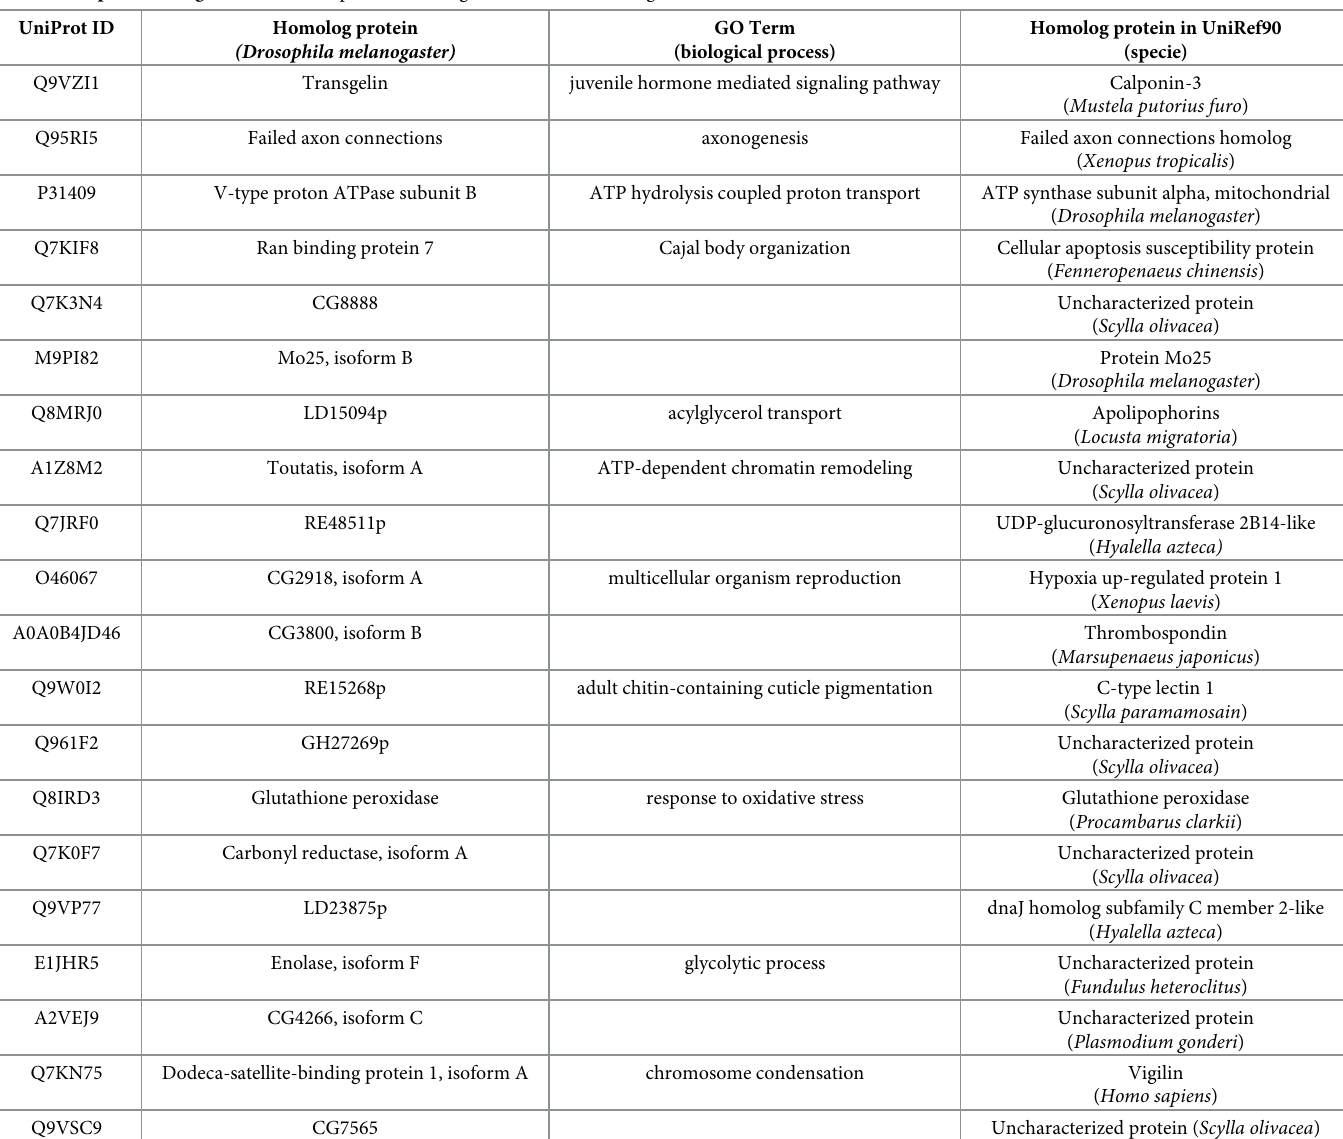
Table 3. Top 20 of hub genes. Network 3 predicted Hub genes and their